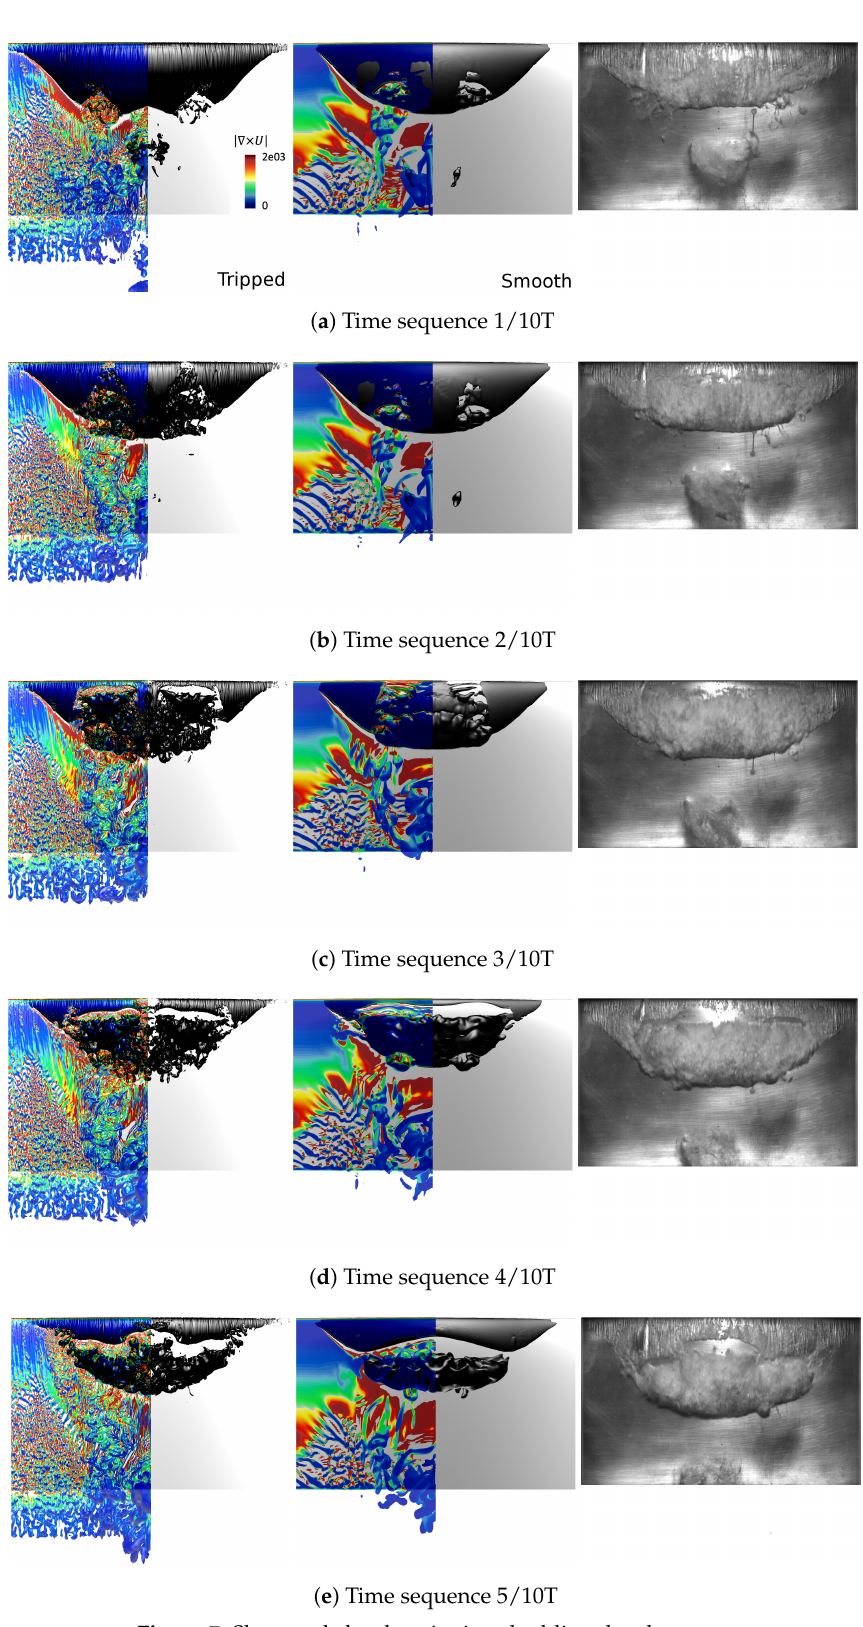
Figure 7. Sheet and cloud cavitation shedding